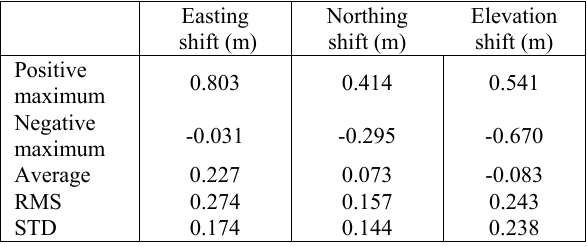
Table 1. The statistics of the initial BLS misalignment.